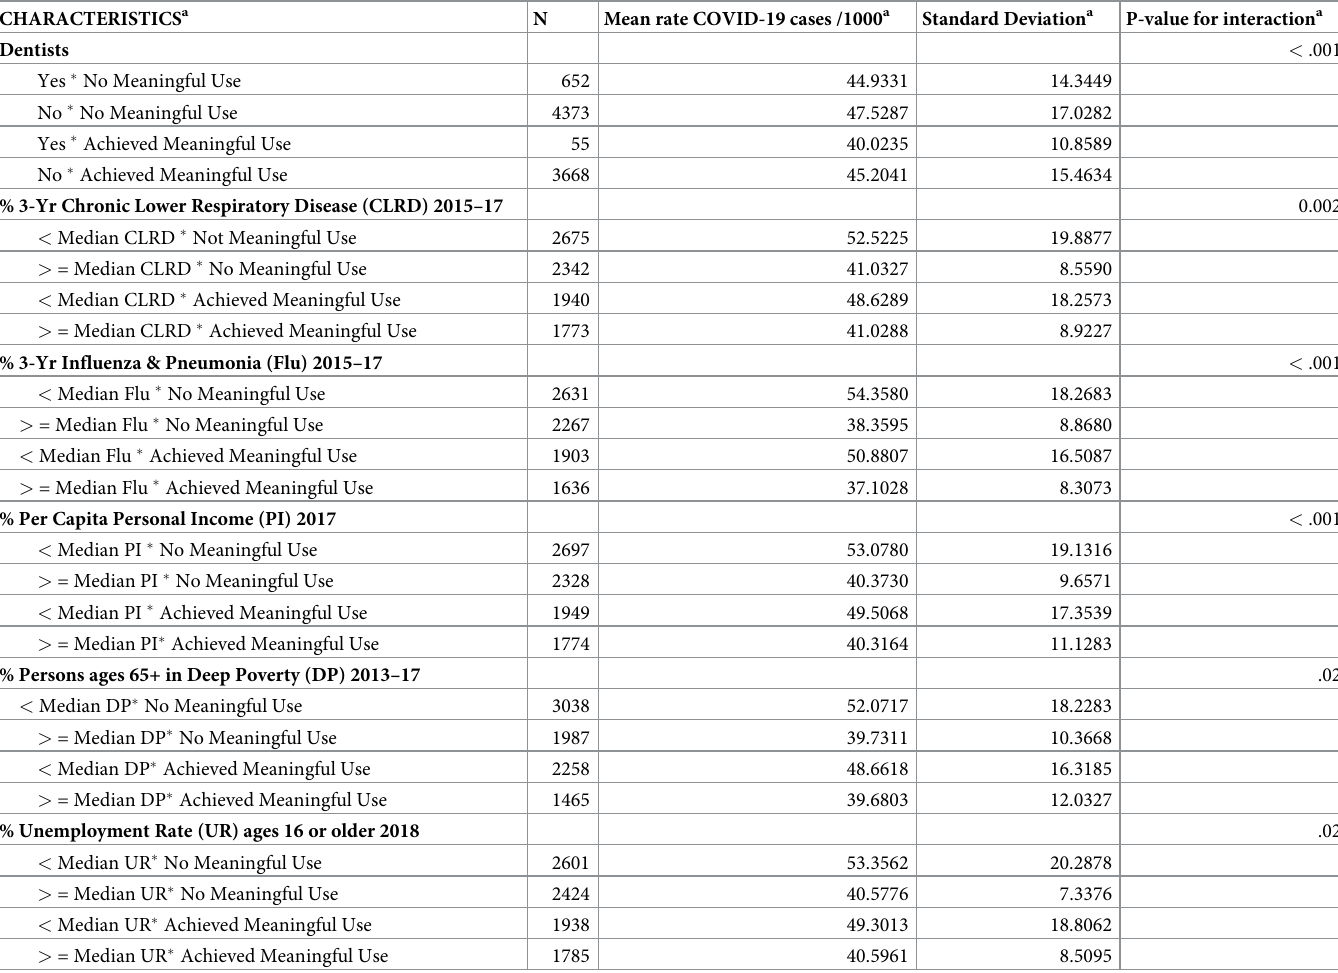
Table 3. Meaningful Use significant interactions with characteristics as they relate to the oncentration of COVID-19 cases / 1000 population. CHARACTERISTICS